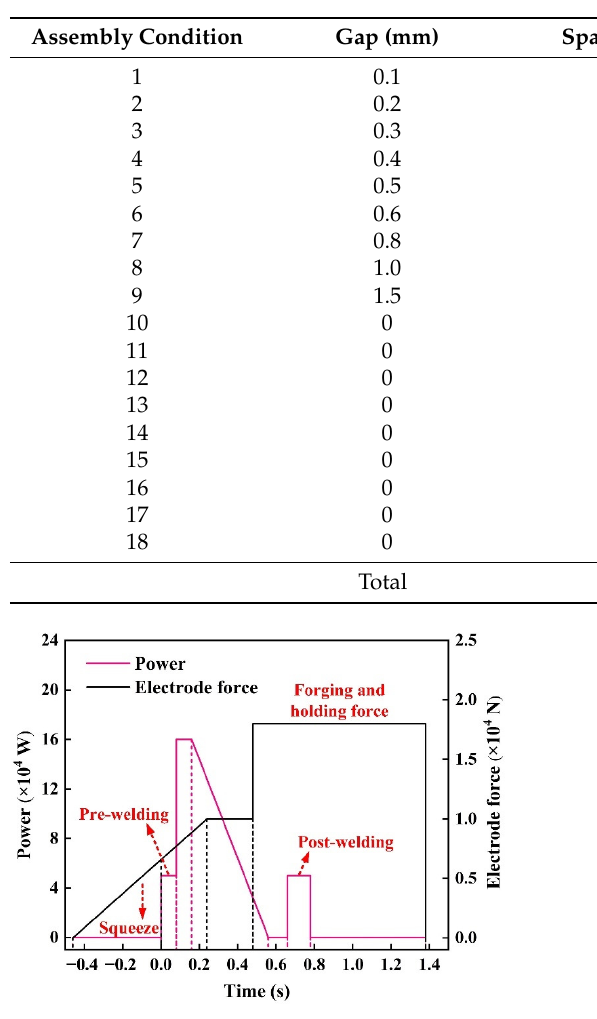
Figure 1. Welding conditions of workpieces and part of stripped weldment: ( a ) different gap conditions, fixed spacing S = 50 mm; ( b ) different spacing conditions, fixed gap G = 0 mm. Table 3. Number of spots corresponding to different assembly conditions.